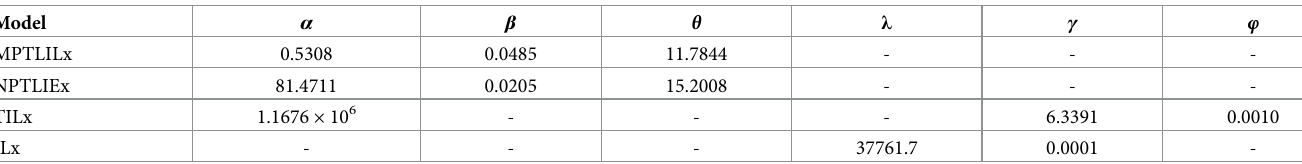
Table 3. Estimates of the second data using MLEs. Model